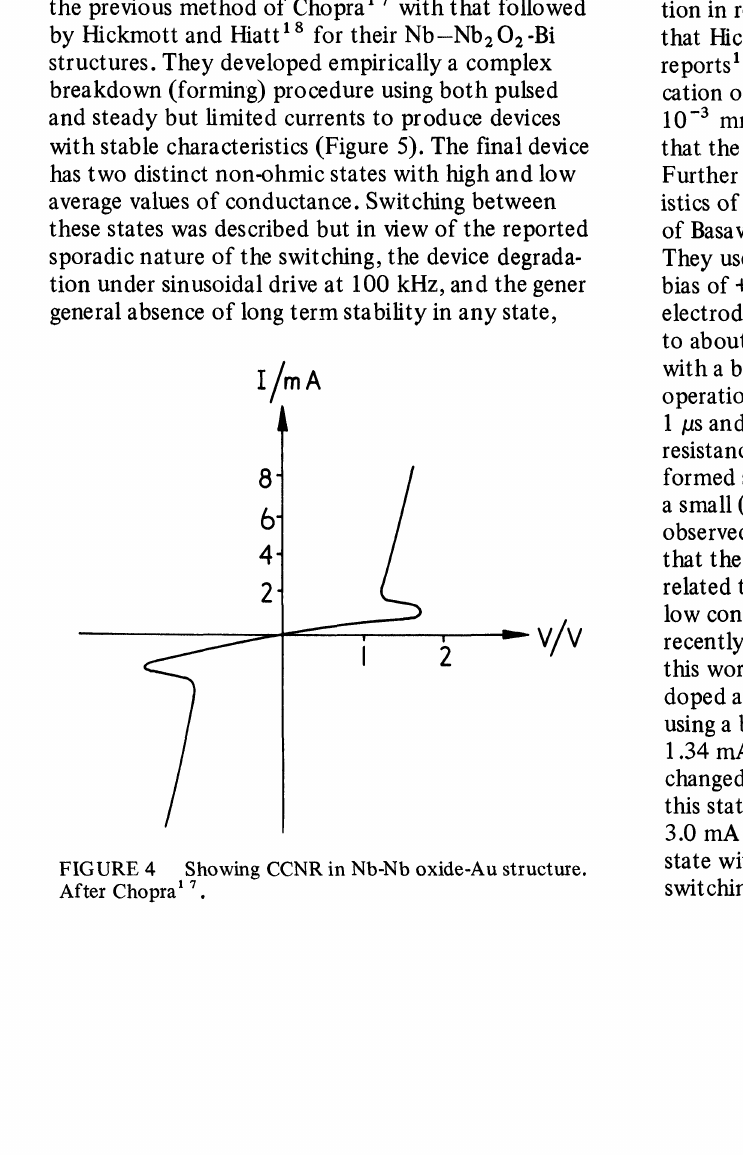
Showing memory states for Nb-Nb O s-Bi structure. After Hickmott and Hiatt’